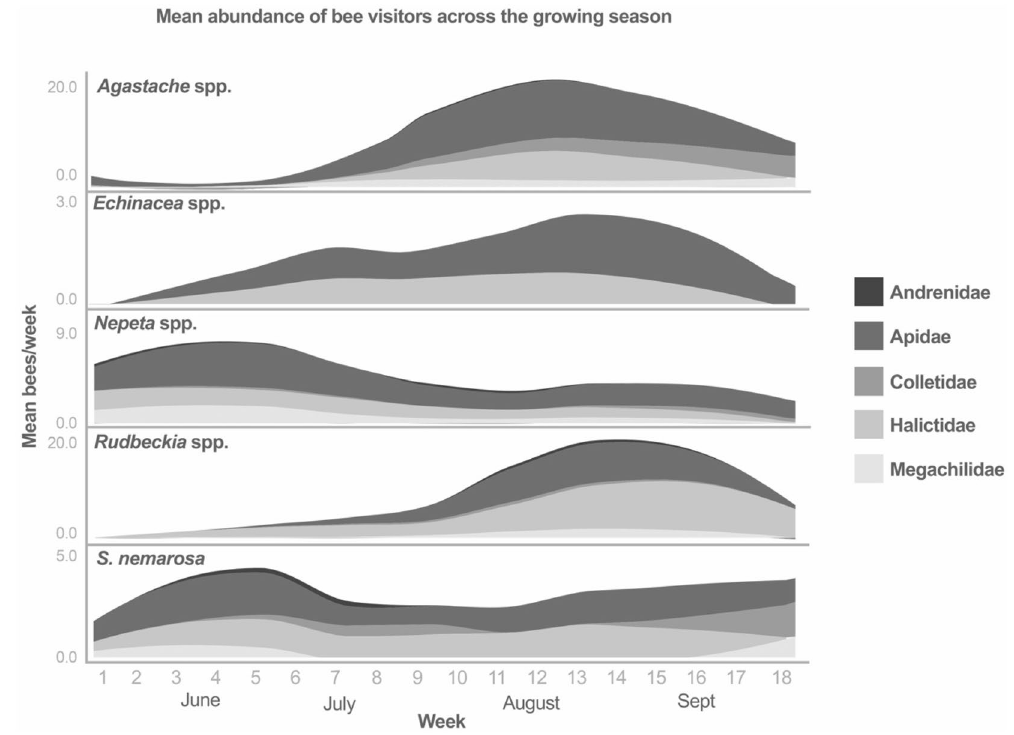
Figure 3. Nepeta spp. and S. nemarosa attract early season visitors while Agastache spp., Rudbeckia spp. and Echinacea spp. attract visitors later in the season. Seasonal patterns of bee visitation correspond closely with cultivar phenology and floral